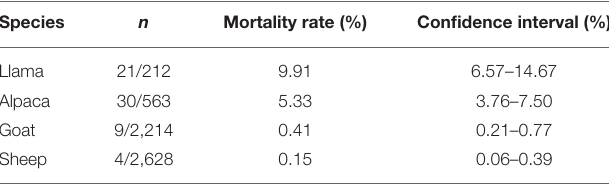
TABLE 1 | P. tenuis -induced mortality by species.